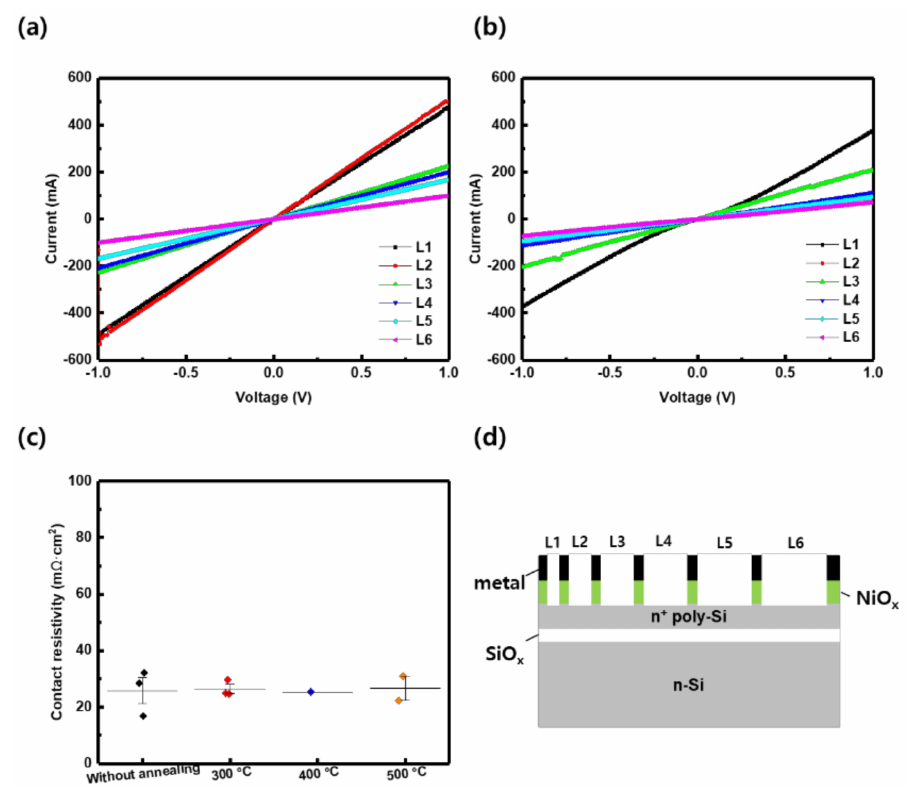
Figure 4. Dark I-V characteristics of Au/NiO x /n + poly-Si structure. TLM structure with NiO x /metal spacing of 0.2, 0.4, 0.8, 1.2, 2.0, and 3.8 mm: ( a ) with annealing; ( b ) without annealing; ( c ) contact resistivity according to annealing temperature; ( d ) test sample structure.